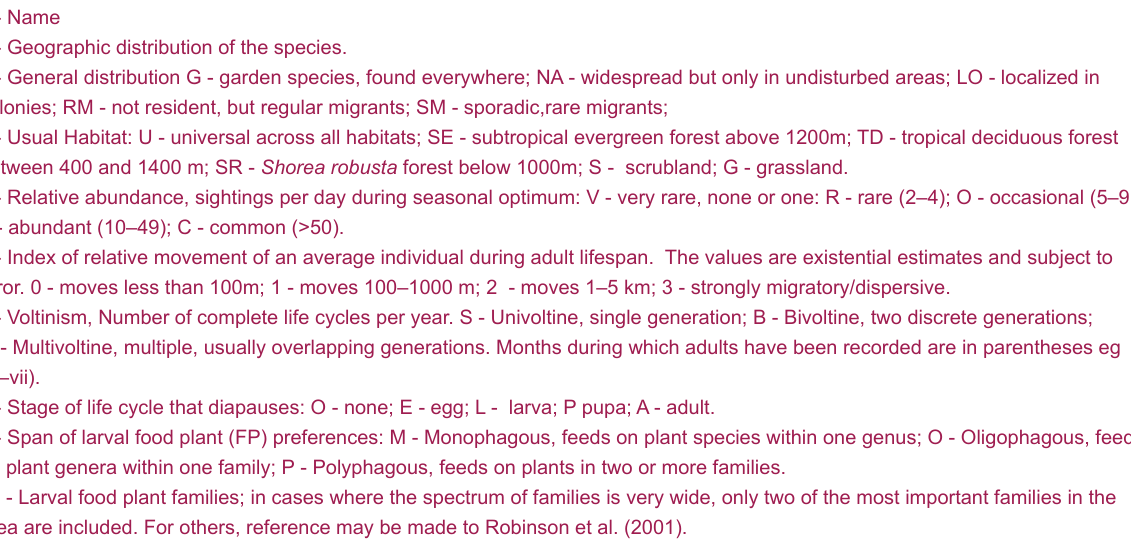
Table 1. Butterflies recorded in Jones Estate, Bhimtal, Between 1951 and